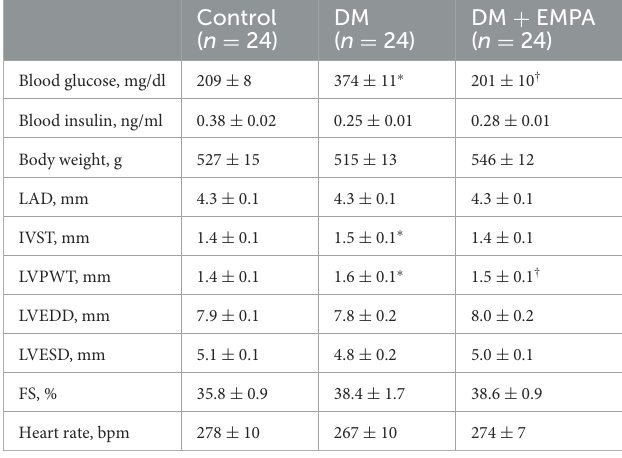
TABLE 1 Characteristics of rats in three